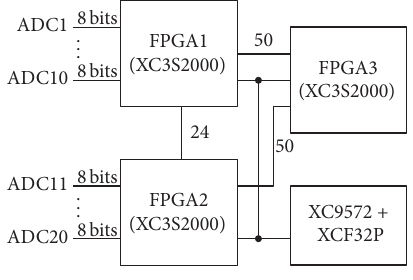
Figure 9: The diagram of Multi-FPGA system.